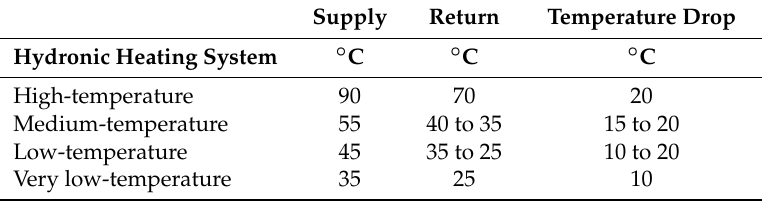
Table 1. Classification of hydronic heating systems according to Boerstra et al. [19]. Supply Return